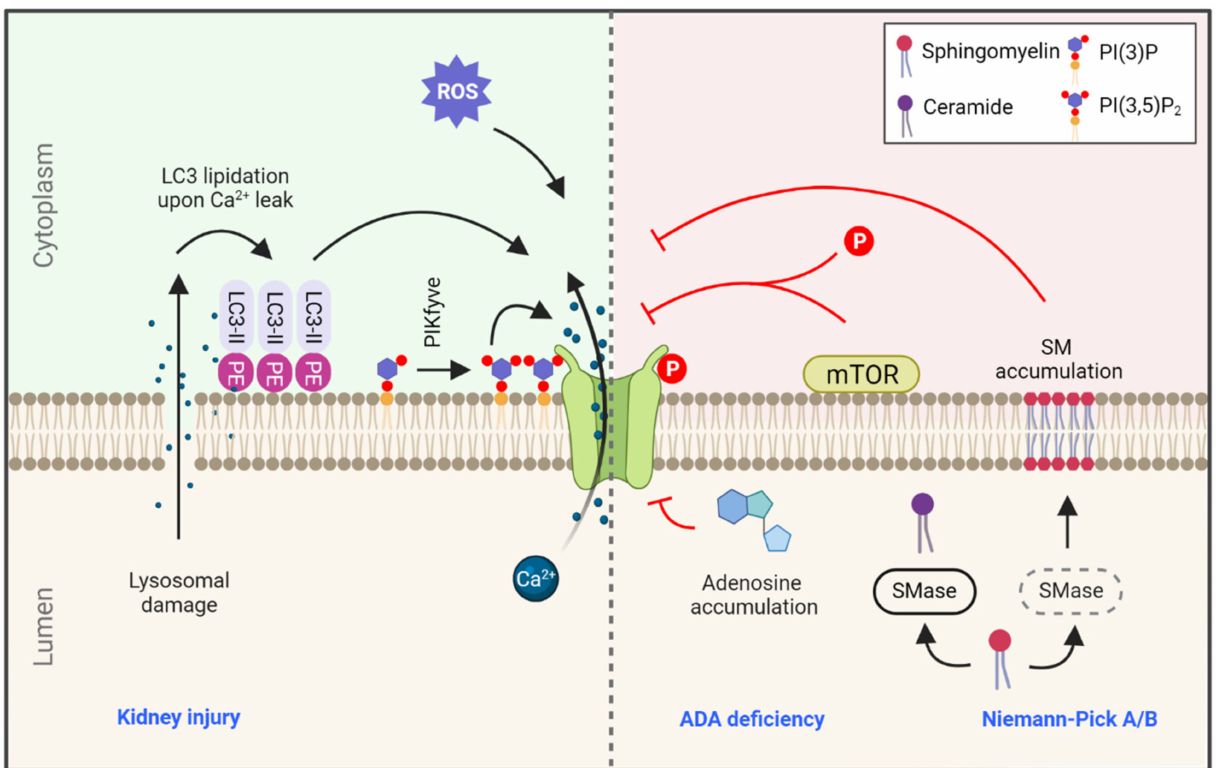
Figure 2. Regulation of TRPML1 in health and disease. TRPML1-mediated calcium efflux is regulated by a variety of signals, such as calcium leakage during lysosomal damage leading to LC3 lipidation at the lysosomal membrane. This lysosome- localized LC3-II is a potent activator of TRPML1. ROS levels and phosphatidylinositol 3,5-bisphosphate (PI(3,5)P2) also positively regulate TRPML1 function. On the contrary, accumulation of adenosine due to ADA deficiency and accumulation of SM in the lysosome due to SMase deficiency in Niemann-Pick type A/B are strong inhibitors of TRPML1 activity. Lastly, TRPML1 is also regulated by mTOR phosphorylation, and consequently by small molecules that regulate mTOR activity (rapalogs; see text). Blue text indicates related diseases. SMase: sphingomyelinase, ADA: adenosine deaminase, PE: phosphatidylethanolamine, PIKfyve: phosphoinositide kinase, FYVE-type zinc finger